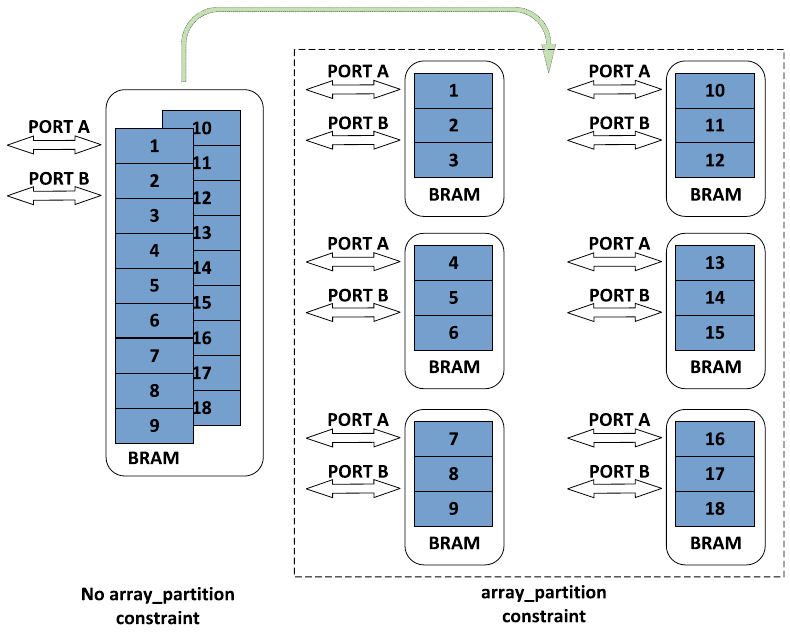
Figure 9. Array_partition constraint